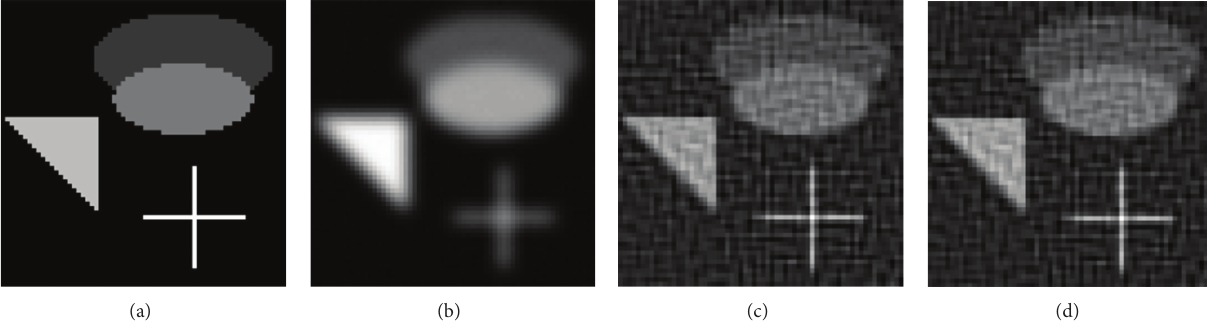
Figure 5: (a) True image, (b) blurred and noisy image, (c) restored image with LSQR, Iter = 95, and REN = 0.3519, and (d) restored image with LSMR, Iter = 129, and REN =